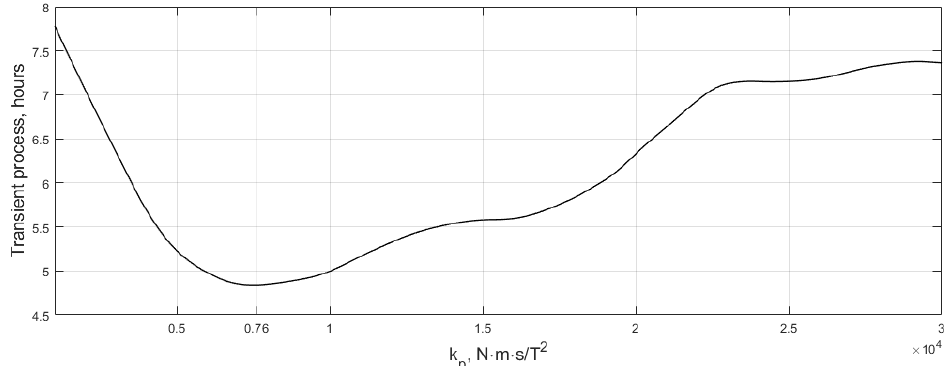
Figure 6. Transient process duration dependence on the positional control gain. Figure 6. Change in the transient process duration due to the disturbances Figure 6 di ff ers signi fi cantly from Figures 2 and 4. The total stabilization time